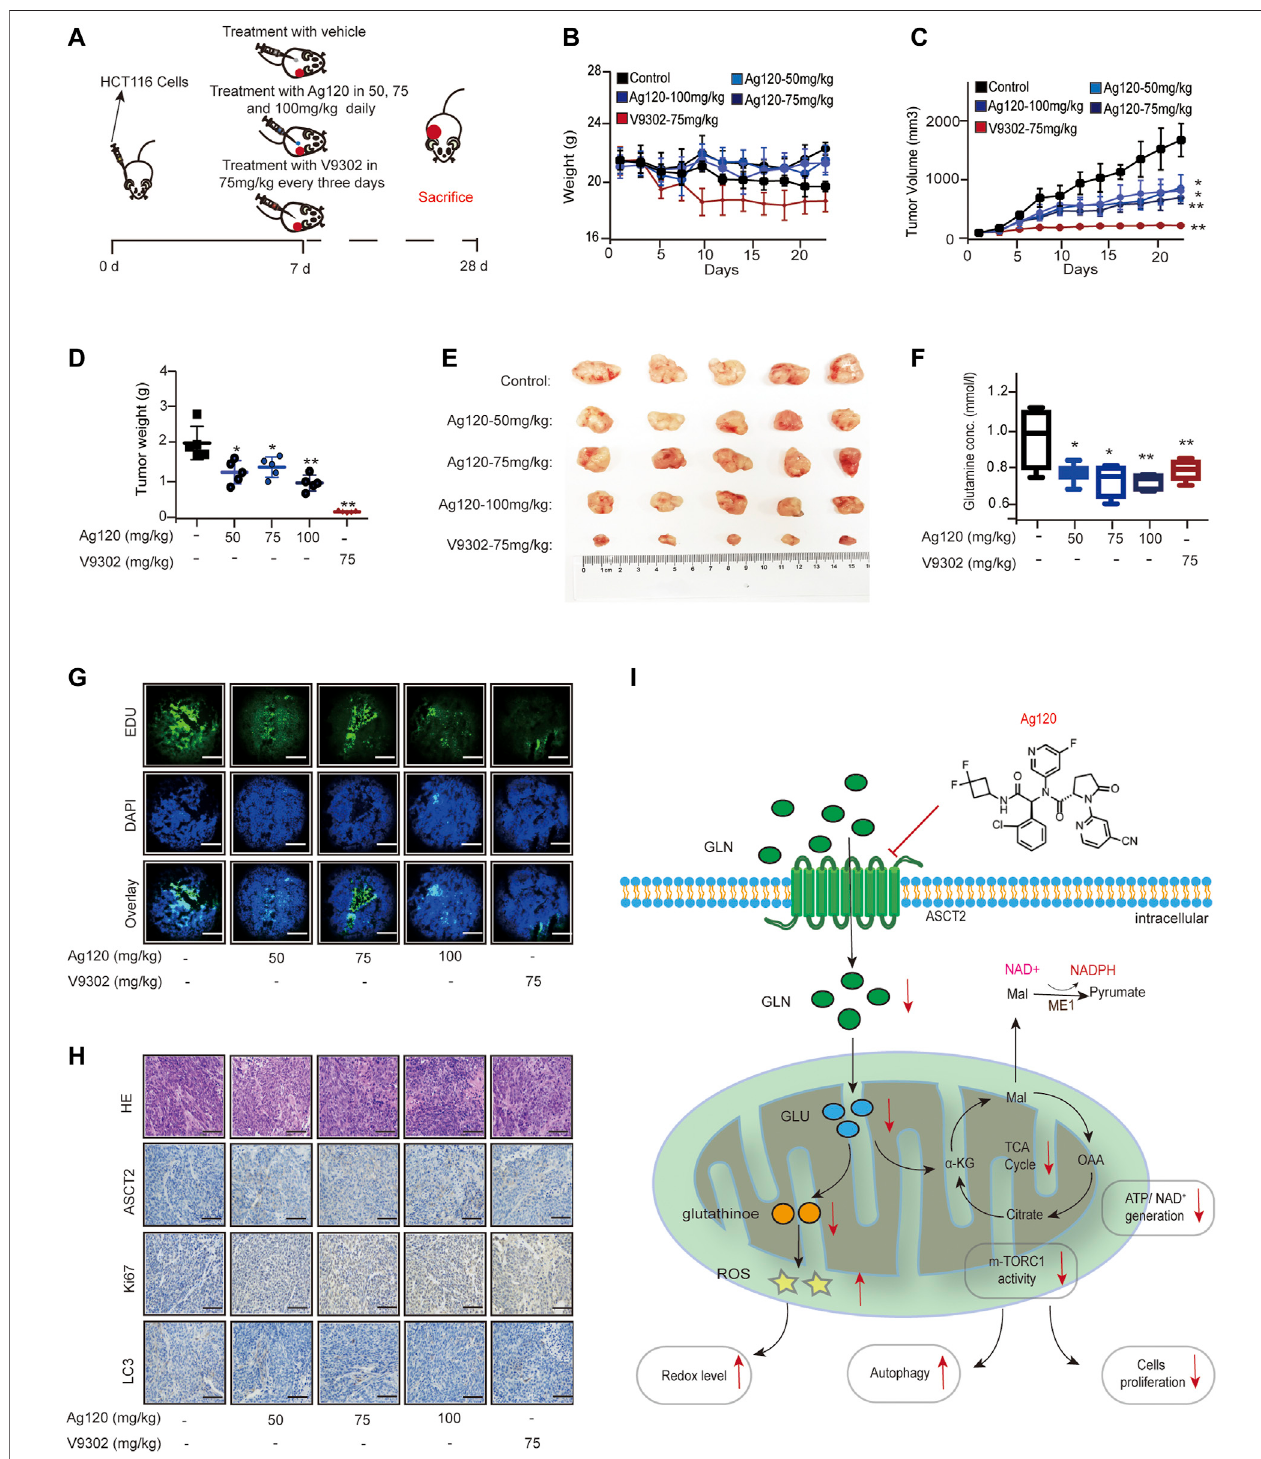
FIGURE6| Effect ofAg120 on HCT116 xenograftgrowth inmice. (A) Experimental protocol. Groups ofathymic BALB/c nude mice wereinjected subcutaneously with 10 6 HCT116 cells and treatments were initiated 7 days later. Ag120 was injected once daily and V9302 was injected every 3 days via the intraperitoneal route. On day 28, animals were sacri fi ced and tumors and blood samples were collected for analysis. (B) Body weight change. (C) Tumor volumes. (D,E) Weights (D) and photographs (E) of tumor xenografts excised on day 28. (F) Blood glutamine levels on day 28. (G) Fluorescence microscopy images of EdU incorporation in sections of excised tumors. Scale bars, 50 µm. (H) Representative images of ASCT2, Ki67, and LC3 immunostaining in sections of excised tumors. Scale bars, 50 µm. (I) Schematicdiagramoftheproposedanti-tumor mechanism ofaction ofAg120 via regulationofglutamine metabolisminCRC cells.Mean±SDof fi vemice pergroup. Symbols represent individual mice. * p < 0.05, ** p < 0.01 by Student ’ s t -test.